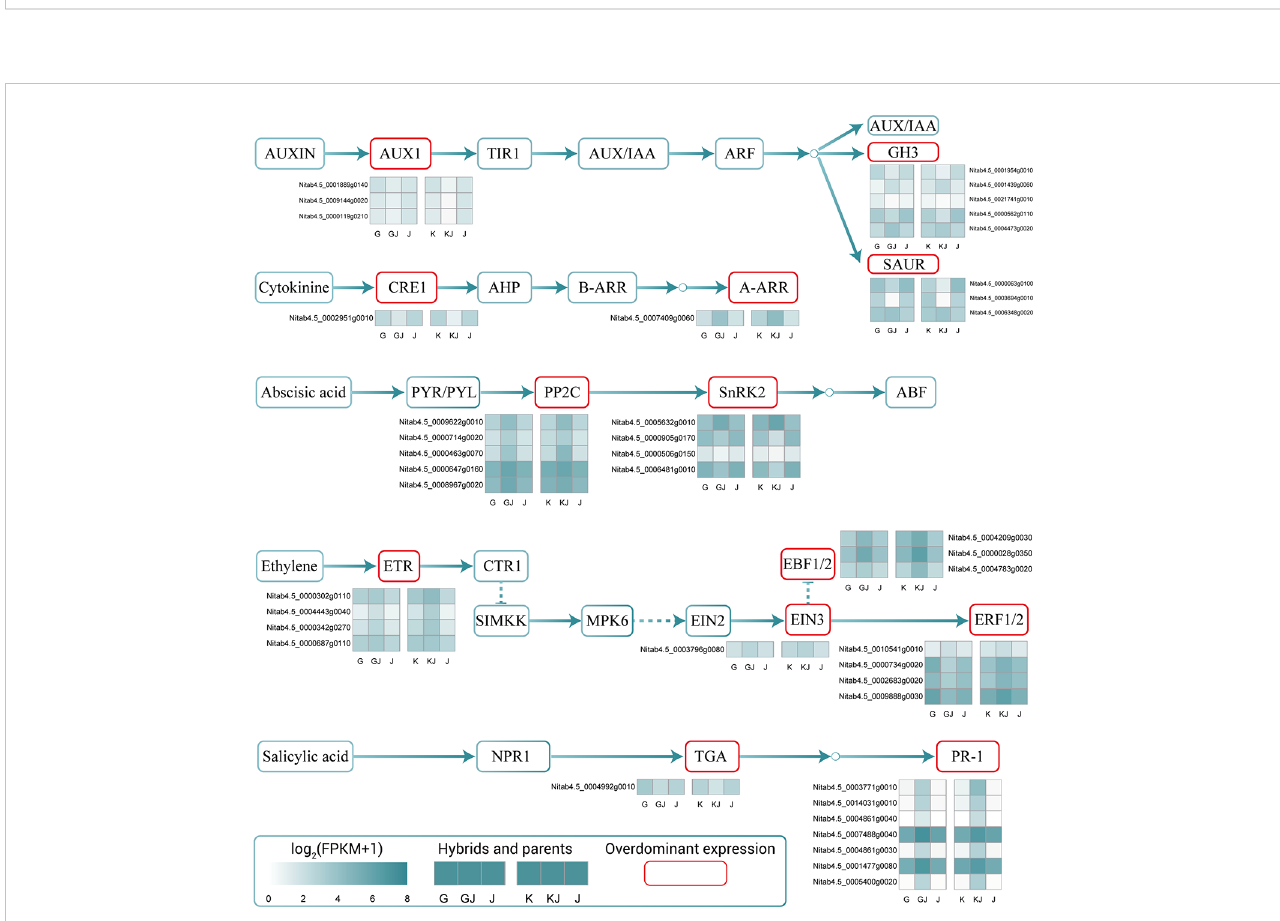
FIGURE 6 Overdominant expression genes of hormone signal transduction related to AUX, CTK, ABA, ET and SA biosynthesis. These genes showed overdominant expression in both